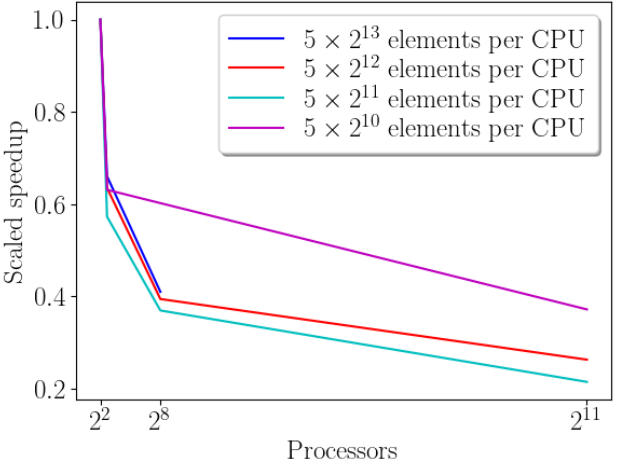
Figure 6. Scaled speedup of a parallel simulation of the TGV benchmark. The number of elements per processor remains